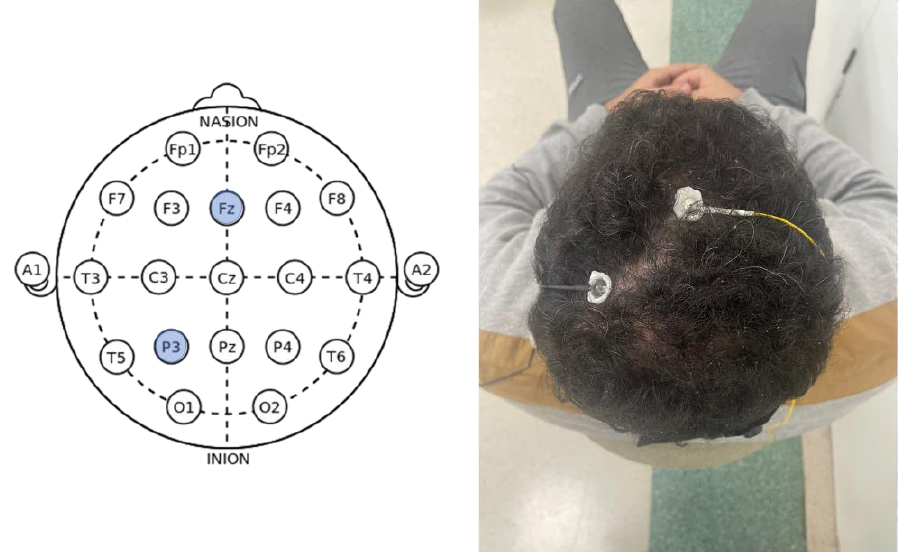
Figure 3. Left : Electrode placement following the 10–20 international EEG system; Right : Reference and recording electrode placements.